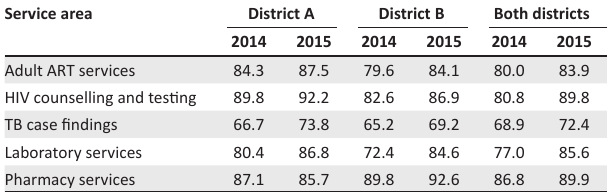
TABLE 2: Percentage performance in the service areas by districts and